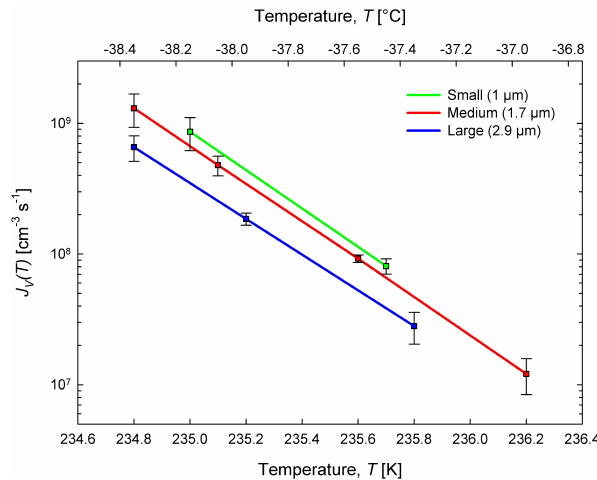
Fig. 12. Volume-based homogeneous nucleation rate coefficients, J V (T ) , determined from model fits to groups of experiments for small, medium, and large